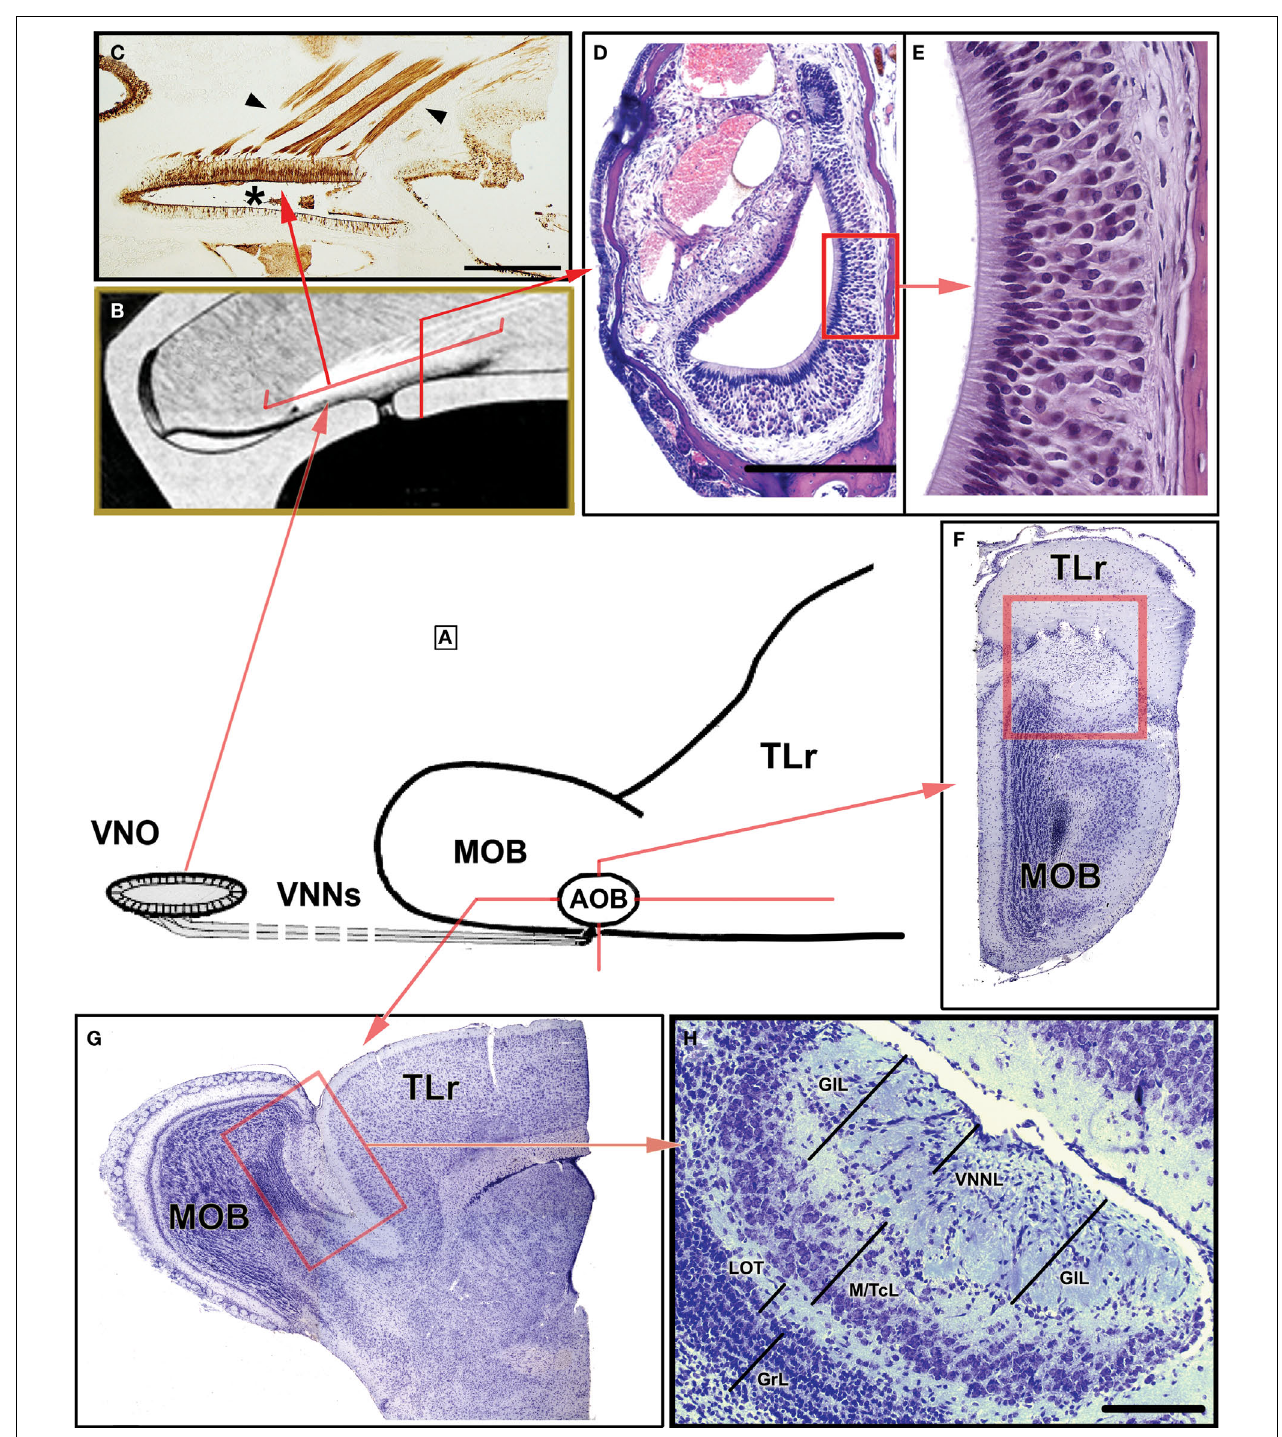
FIGURE 1 | Certain morphological characteristics of the VNO and AOB in mice. (A) Schematic representation of the arrival of the VNNs from the VNO to the AOB. (B) Drawing of the nasal cavity where the VNO is located, showing the orientation plane in (C) and (D) . (C) Parasagittal section of the nasal septum stained by UEA-I. The VNNs (arrowed) and the neuroepithelium of the VNO (asterisk) bind to UEA-I. (D) Transverse section of the VNO stained with haematoxylin-eosin. (E) Magnifi cation of the box in (D) , showing the neuroepithelium of the VNO.